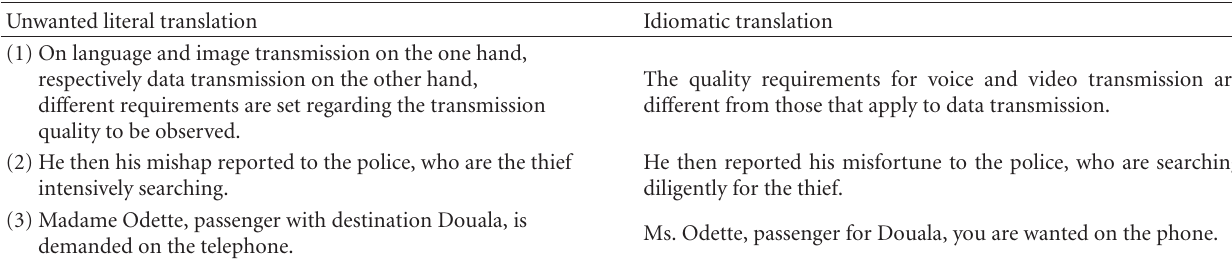
Table 1: Examples of unwanted literal translations and idiomatic